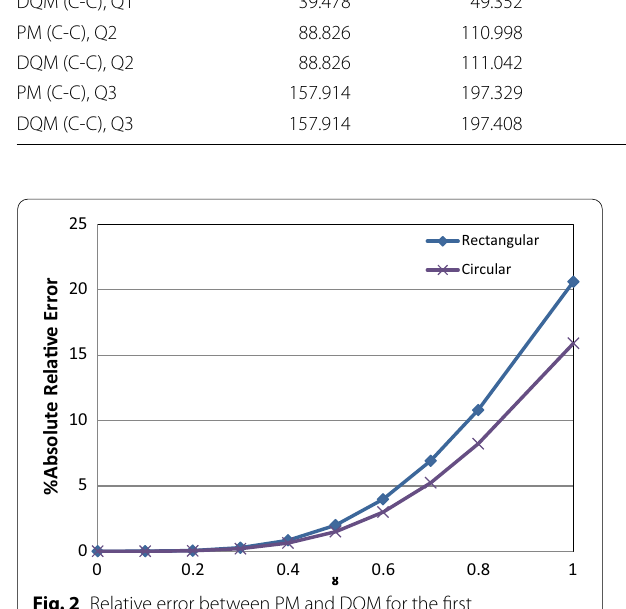
Fig. 2 Relative error between PM and DQM for the first non-dimensional frequency of non-prismatic